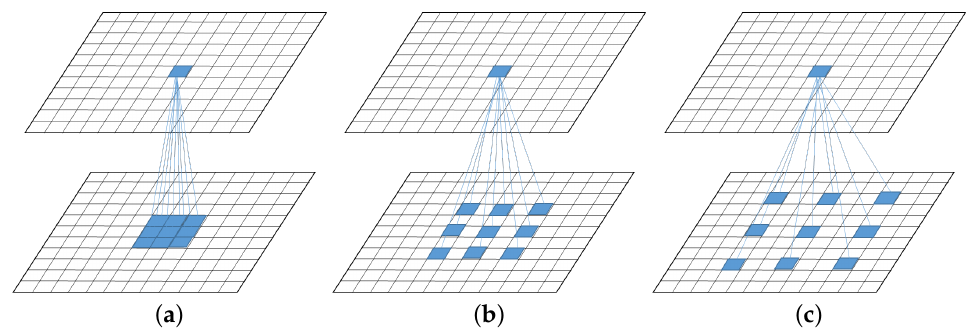
Figure 1. Receptive fields of 3 × 3 dilated convolution at different dilation rates. ( a ) d = 1. ( b ) d = 2. ( c ) d =